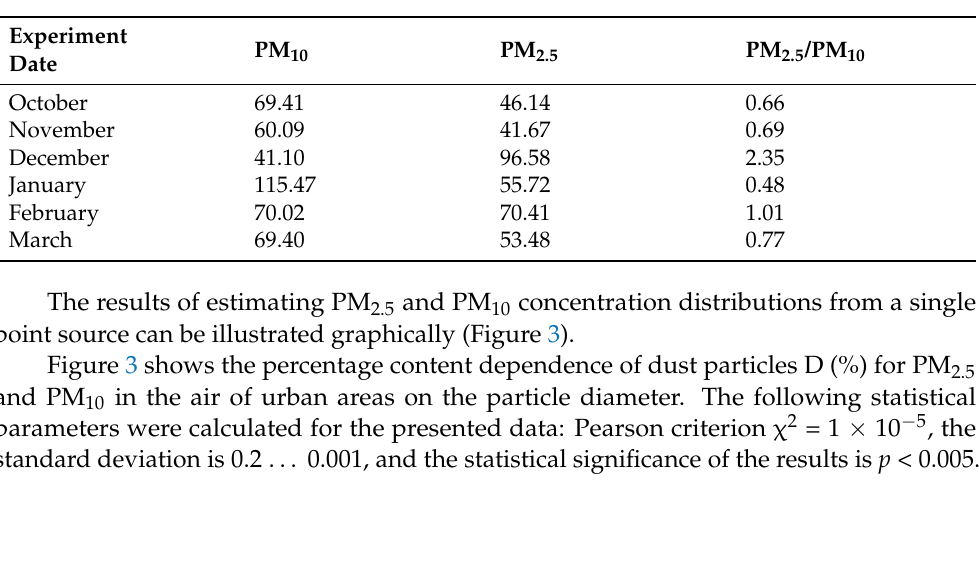
Table 2. Statistical characteristics of the PM 2.5 to PM 10 mass ratio in Chelyabinsk in the